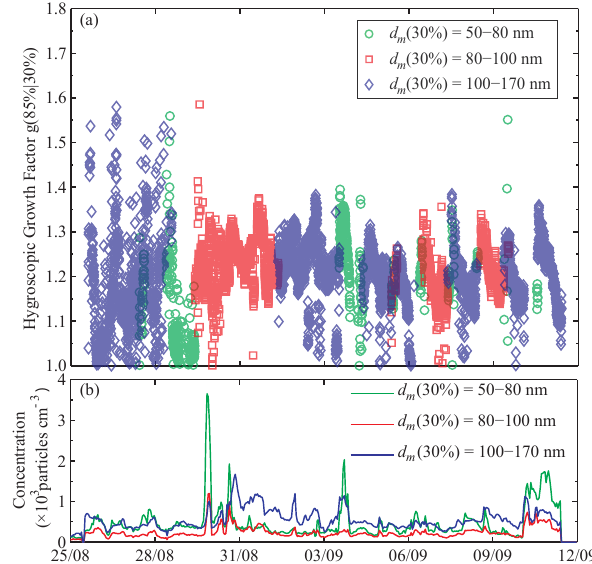
Fig. 4. Time series of the hygroscopic growth factors of atmospheric aerosol particles measured with the HTDMA (a) and number con- centrations of the particles having dry mobility diameters in the ranges sampled by the HTDMA (b) at the ground station on Lem- nos Island. Aerosol particles are grouped in three different regions based on their dry mobility diameters: from 50 to 80nm (green cir- cles and curve), from 80 to 100nm (red squares and curve), and from 100 to 170nm (blue diamonds and